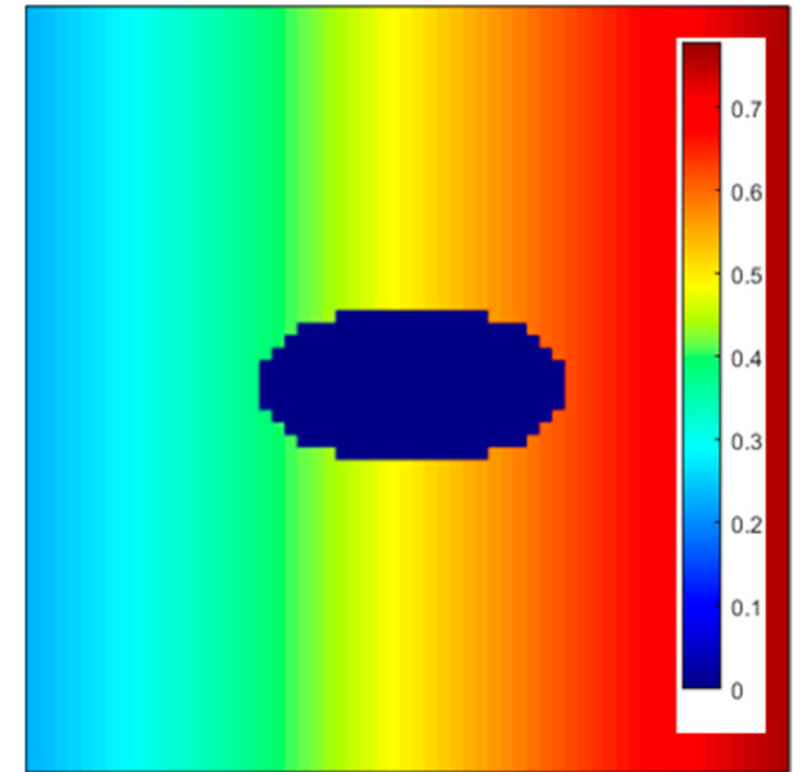
Figure 3. I X field of an ellipse with AR =